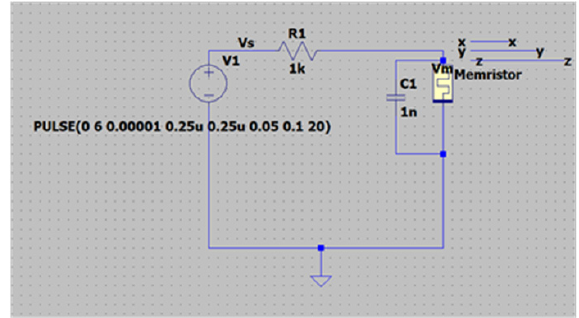
Figure 7. LIF neuron simulation circuit with volatile memristor.